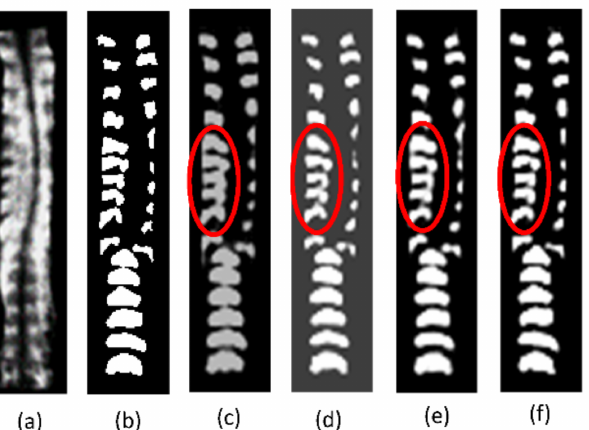
Figure 11. Individual segmentation result of the spine ultrasound image: ( a ) Raw image, ( b ) truth